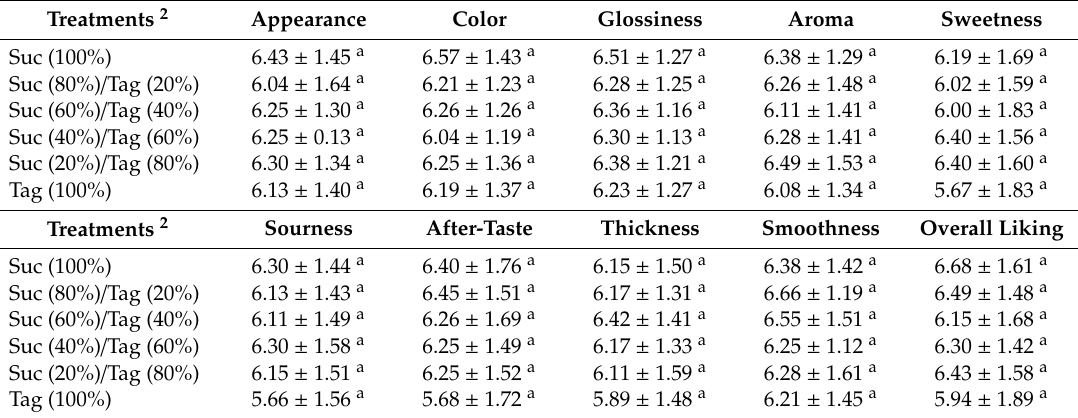
Table 4. Mean values 1 for the sensory acceptability scores of the strawberry-flavored